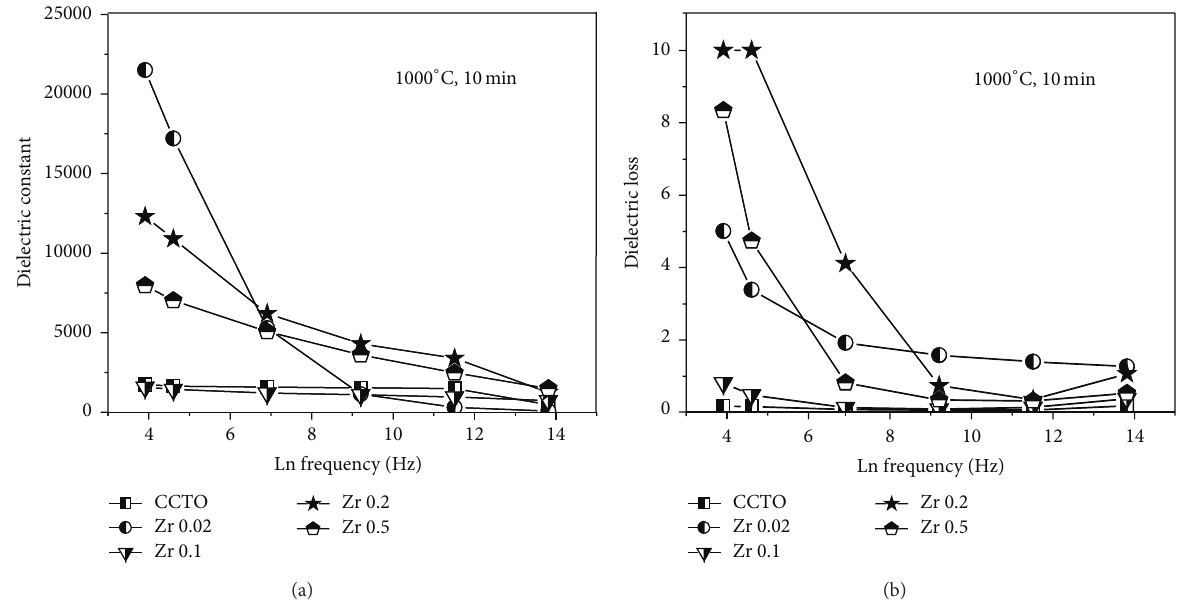
Figure 3: Frequency dependence of the dielectric constants and dielectric loss of Zr doped CCTZO ceramics sintered using microwave at 1000 ∘ C for 10min. Table 1: Dielectric constant and loss of CCTO and zirconium dopants using microwave sintering at 1000 ∘ C for 10min. 𝑥 = 0 𝑥 = Frequency Hz